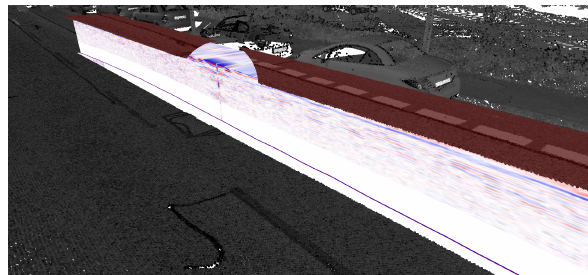
Figure 5. Points under the cuboid are elevated and highlighted.